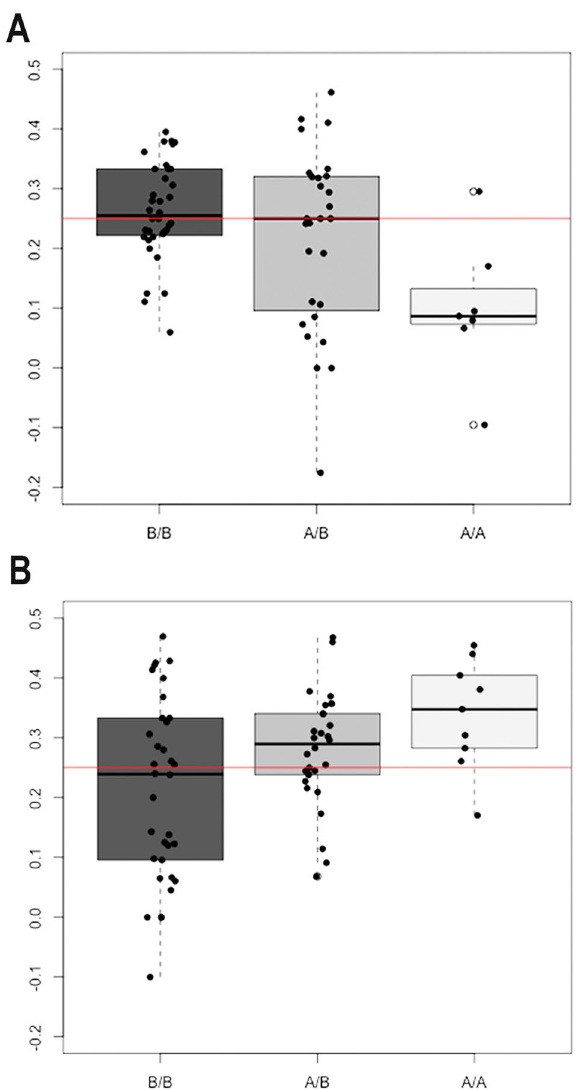
Figure 2. Correlation between copy number of the MLIP locus and intraocular pressure (IOP) reduction response to timolol maleate ( A ) and to latanoprost ( B ). Boxplots in each panel shows the percentage distribution of IOP reductions for individuals (black dots) grouped according to their MLIP genotype (B: no copy; A: 1 copy). The horizontal red line marks a 25% IOP reduction that differentiates responders from non-responders. Panel A. IOP reduction in response to a beta-blocker (timolol maleate). More copy numbers (AA genotype) tend to be associated with a smaller percentage IOP reduction, while the median response is higher among individuals with 1 or no MLIP variant copy. Panel B. Individual responses to prostaglandins (latanoprost) and their genotypes. Individuals with fewer copy numbers show a lower median response to latanoprostf in terms of relative IOP